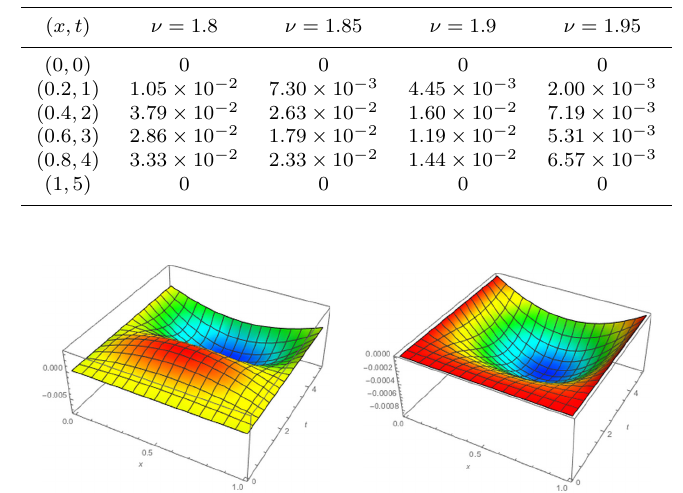
Table 1. Absolute error for different values of ν with β = 1 and M = N = 2 on the interval [0 , 1] × [0 , 5] for Example 2.